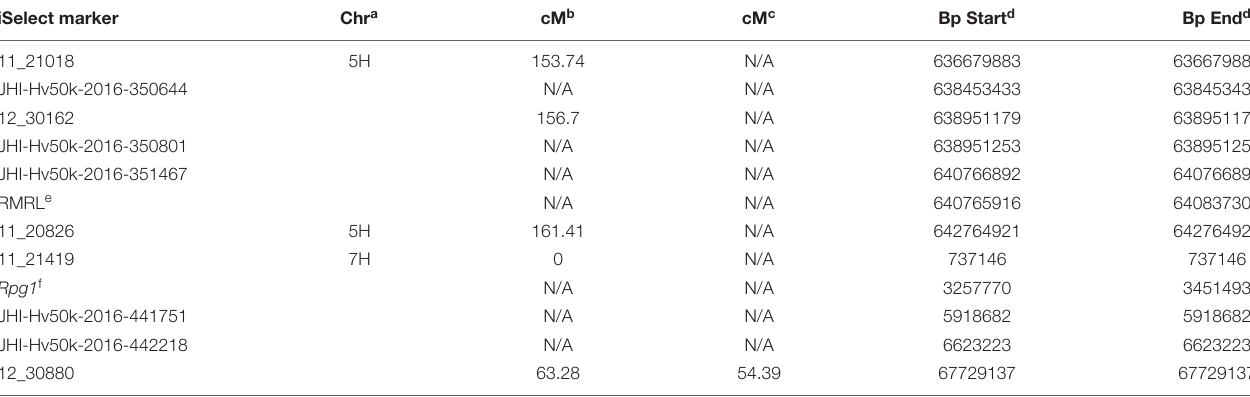
TABLE 2 | Genetic and physical location of markers associated with Rrr1 and Rrr2 . iSelect marker Chr a cM b cM c Bp Start